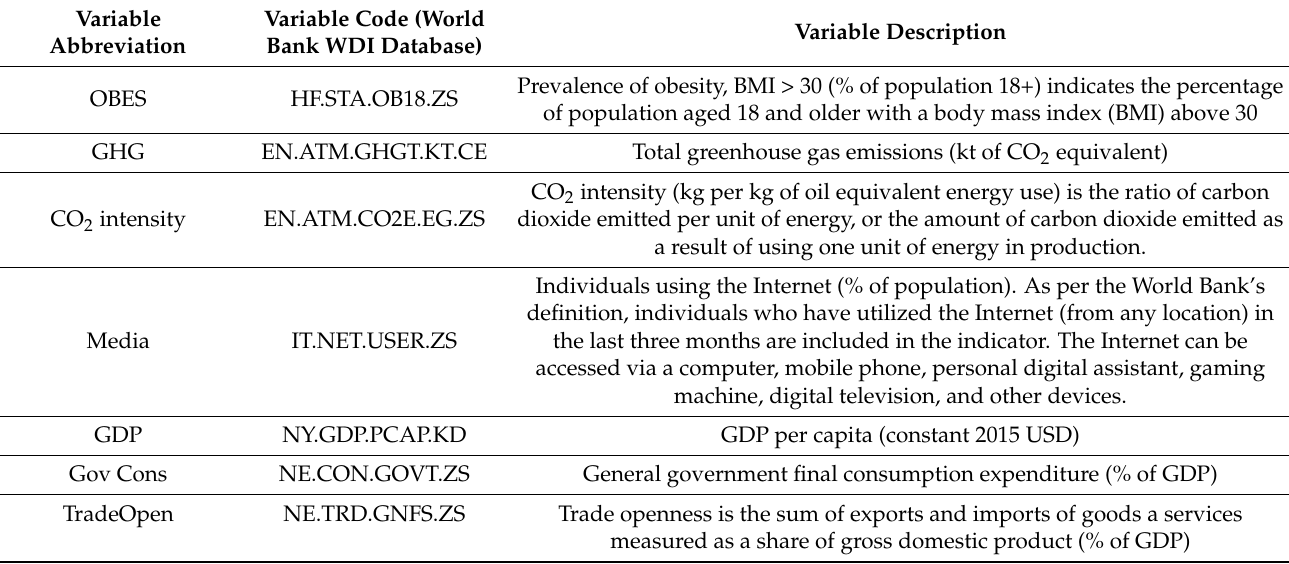
Table 1. Variable description.